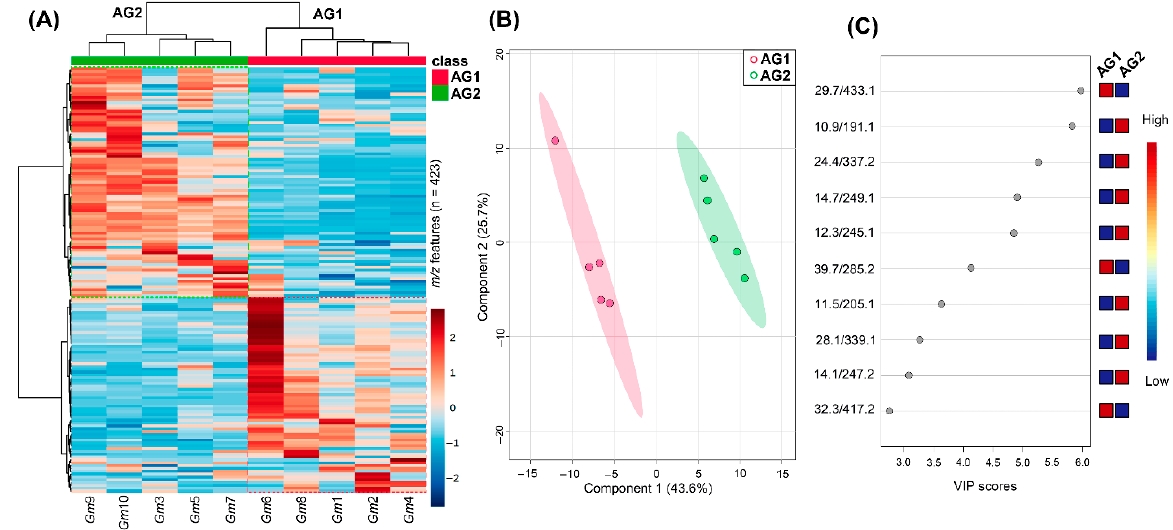
Figure 1. Chemical differentiation of the seed extracts from the ten G. monspessulana , using liquid chromatography coupled to mass spectrometry (LC-MS) profiles. AG1 = accession group 1; AG2 = accession group 2. ( A ) Heat-map-based chemical distribution of the m/z feature intensity detected in G. monspessulana seed extracts ( Gm 1–10). Columns organized each extract in the heat map. Each colored cell was associated with an autoscaled intensity of each detected m/z feature, depending on the color scale (dark red: high intensity; dark blue: low intensity). ( B ) Partial least square–discriminant analysis (PLS-DA)-derived score plot (component 1 (C1) vs. C2); accession grouping used as a categorical variable; variance explained = 69.3%. ( C ) PLS-DA-derived variable importance in the projection (VIP) plot; the ten most influential features were ranked (VIP scores > 2.5); retention time and mass/charge ratio (rt/ m/z ) pairs were used for the chemical identity of each top-ranked feature.